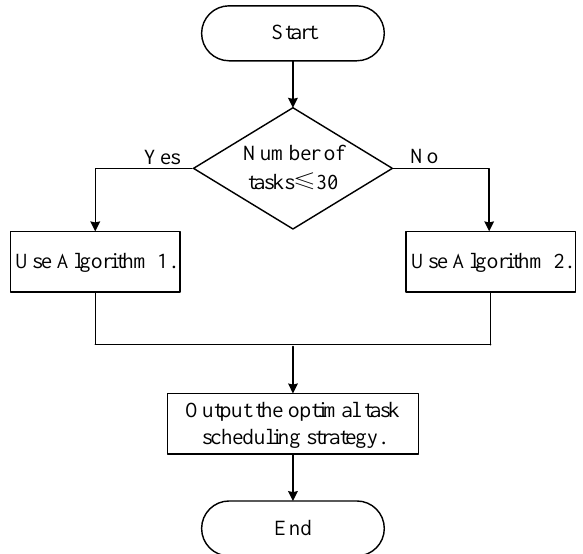
Figure 5. The flowchart of HMA